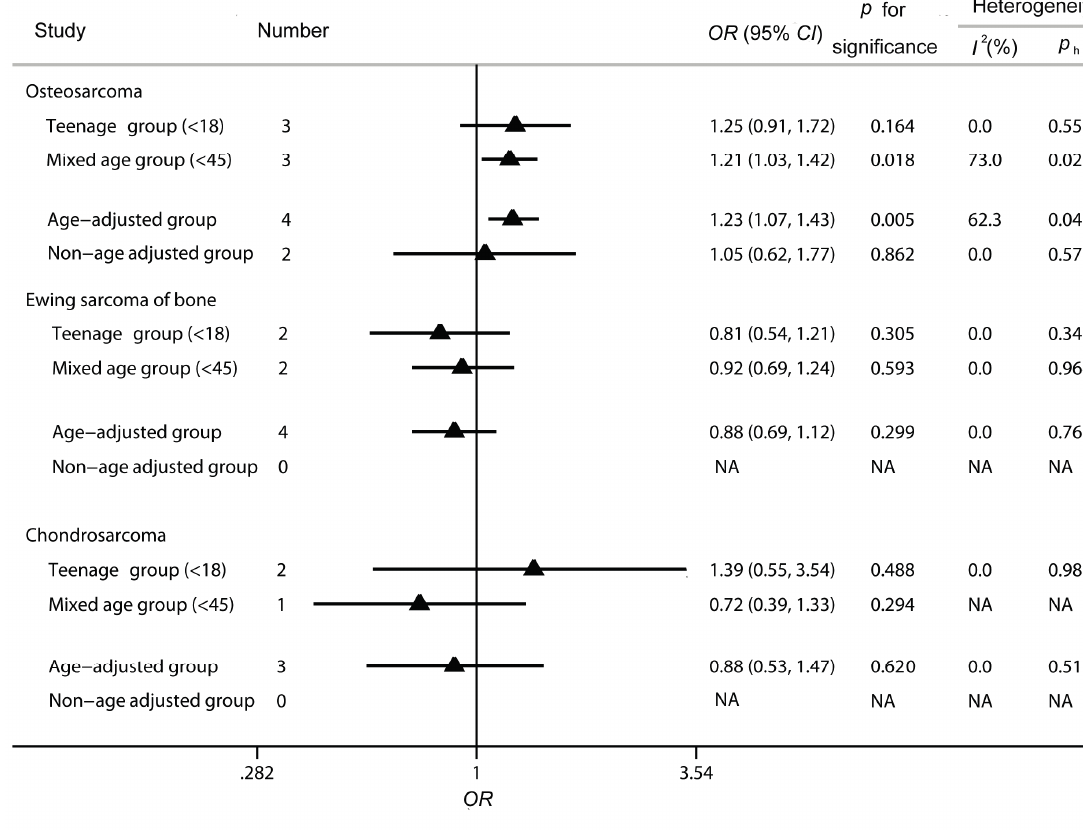
Figure 6. Analysis of the relationship between high birth weight and the risks for the three main subtypes of bone tumor in the age-related groups. “NA” means the data was